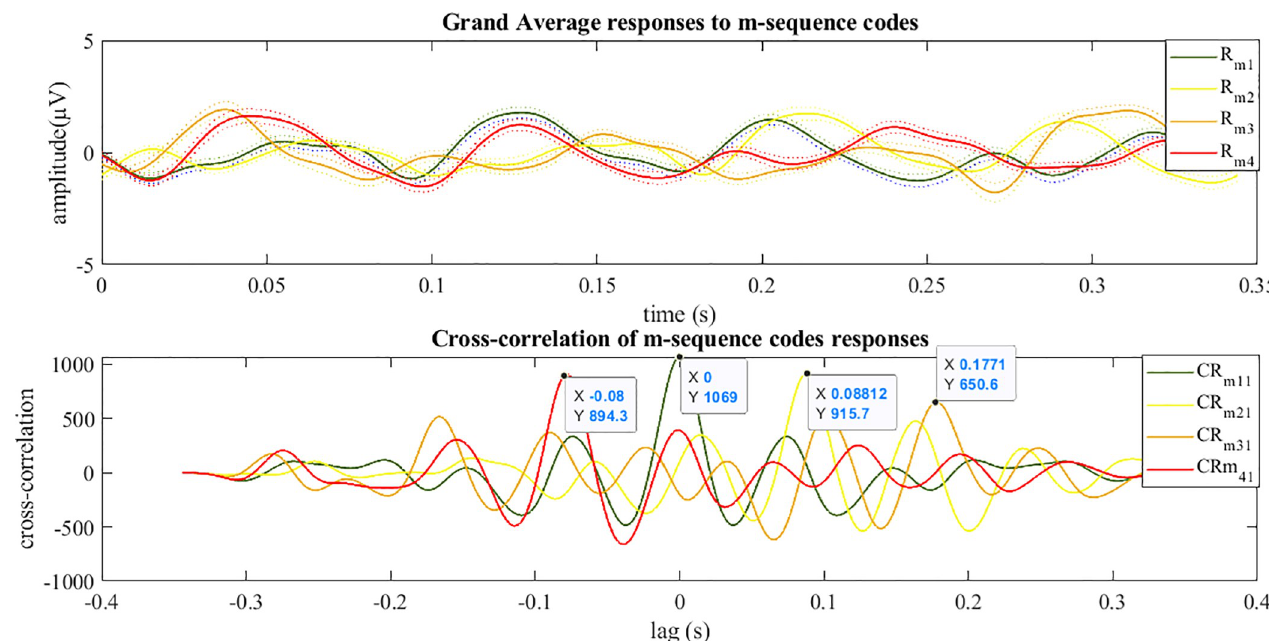
Fig 12. Grand average and cross-correlations of evoked responses to m-sequences. The grand average responses to codes M i ( i = 1:4) is shown with waveforms of R their corresponding standard errors are shown with dotted plots (top) and the auto-correlation of response R m i the responses R ð i ¼ 2 : 4 Þ is shown with the waveforms of CR m i where they are